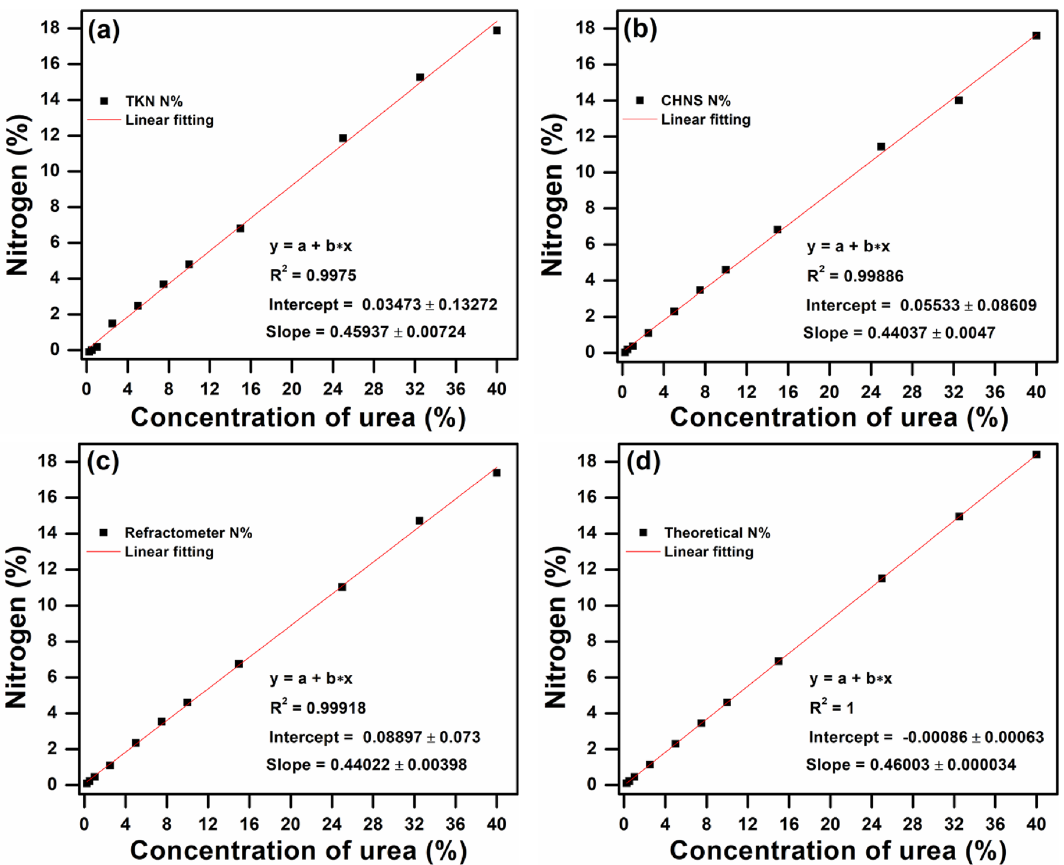
Figure 3. Linear fitting between nitrogen (%) and different concentration of urea ranging from 0.25 to 40% (including DEF at 32.5% urea) for ( a ) TKN, ( b ) CHNS ( c ) refractometer, and ( d ) theoretical N% (Refractometer showed R 2 value is close to the theoretical value for urea analysis).